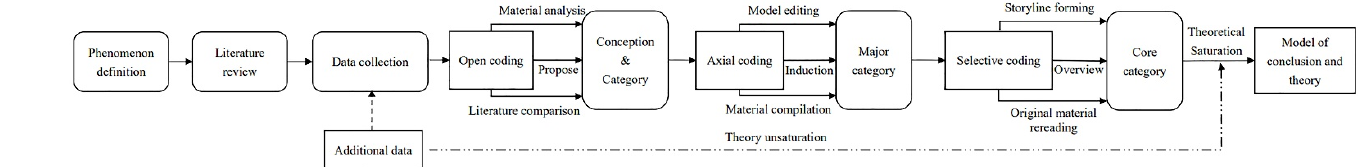
Figure 1. Flow chart of grounded theory.